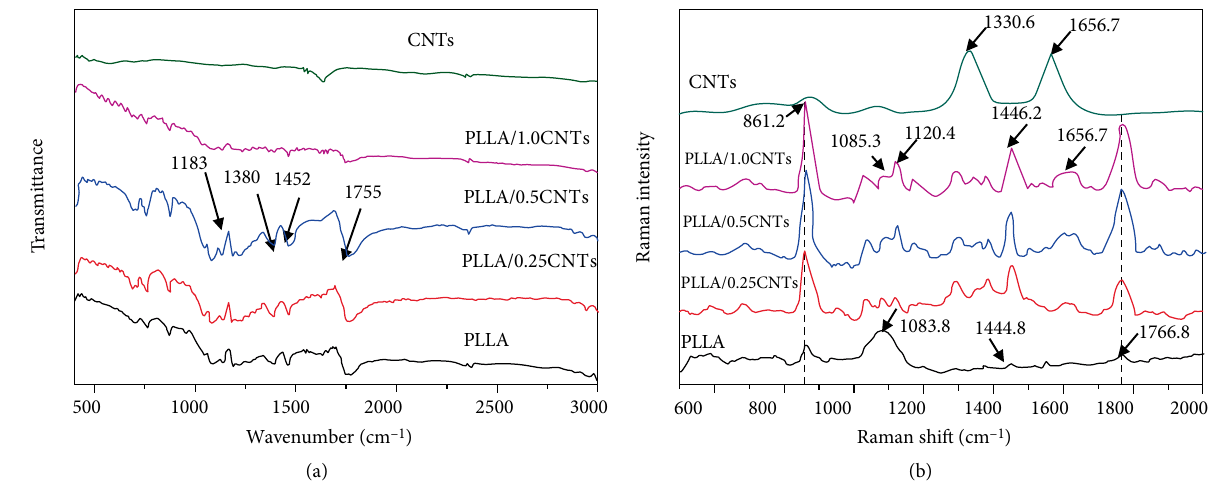
Figure 2: (a) FTIR and (b) Raman spectra of CNTs, neat PLLA, and PLLA/CNTs scaffolds.